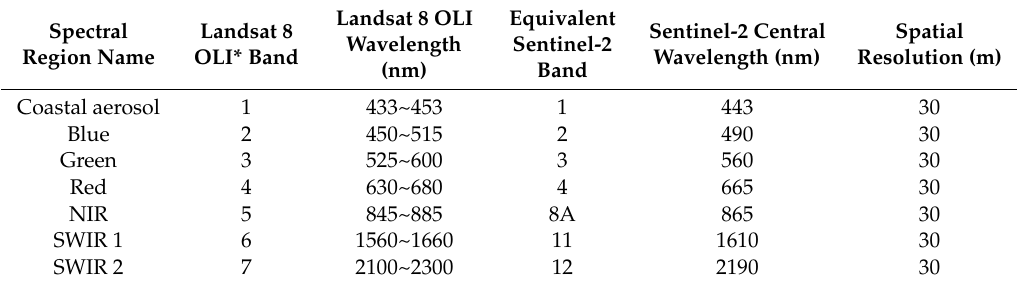
Table 1. Corresponding bands between Harmonized Landsat-8 and Sentinel-2.